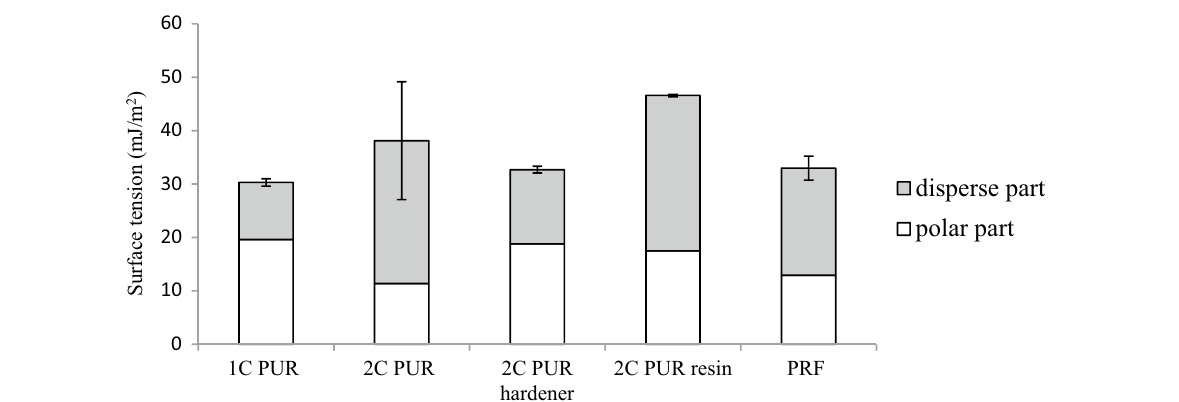
Fig. 1 Disperse and polar parts of surface free energy of different adhesive systems and adhesive components ( n at room temperature in liquid